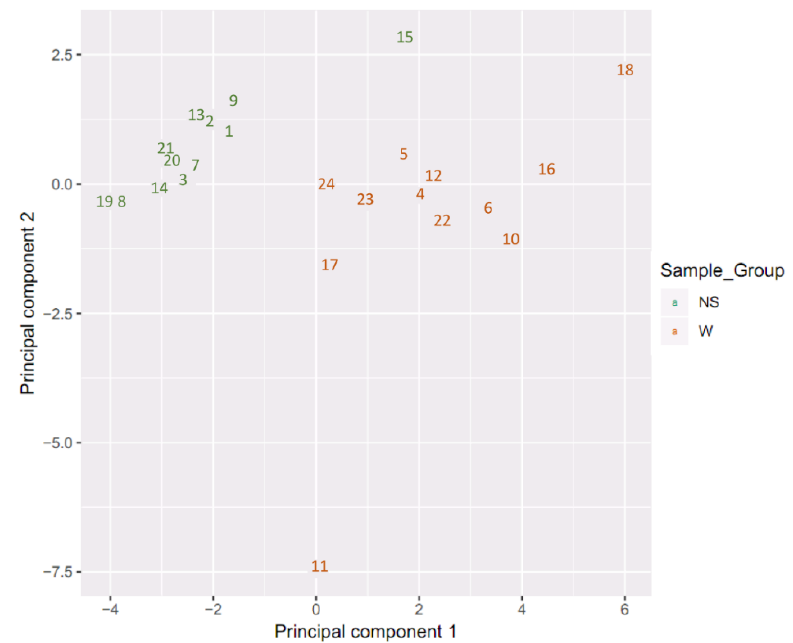
Figure 2. Scatter plot showing normal skin (NS) and wart (W) samples’ coordinates on the first and second principal components. Discrimination between the NS and W samples is shown as in indicated by the color capture.